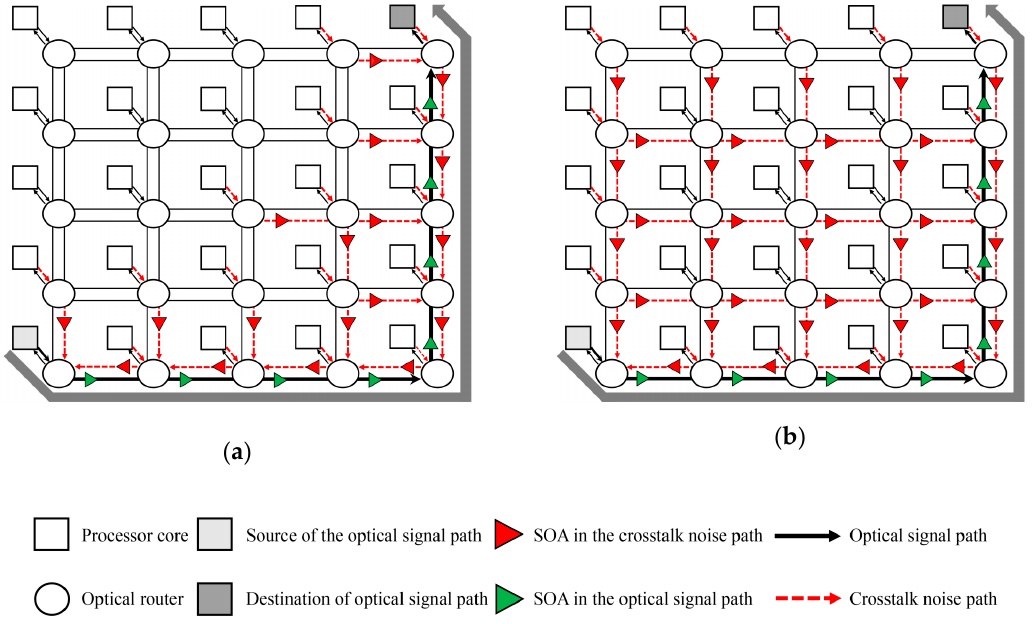
(cid:12) (cid:12) (cid:12) ; (cid:12) L avg